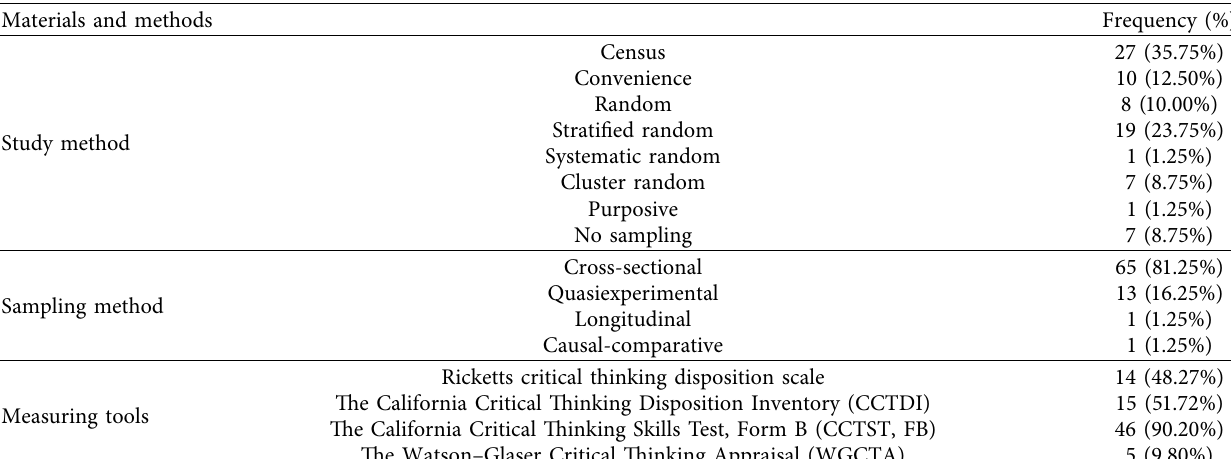
Table 2: Features of materials and methods in